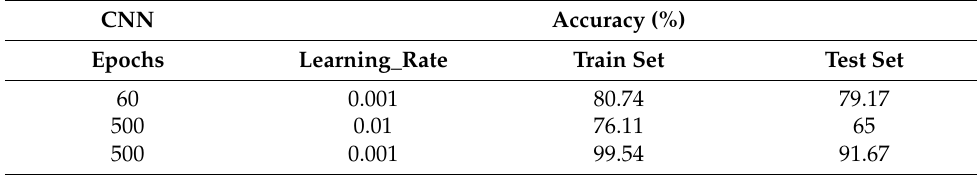
Table 2. Comparative results for the CNN and ResNet